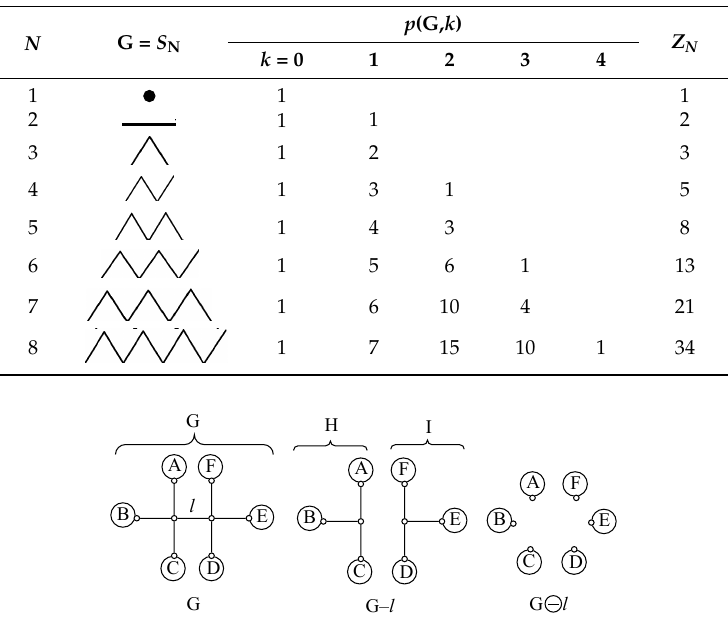
Figure A1. Recursion formula for obtaining Z of G by two-step deleting of edge l . Let us apply this recursion formula to a graph G with ten vertices given in Figure A2. First cut the edge in the middle (the vertical straight dashed line) to obtain G– l ; then, do the second cut (pair of the curved dashed lines) to obtain G Θ l . Take the product sum of all the components according to Figure A1, and we obtain Z = 77 for G.